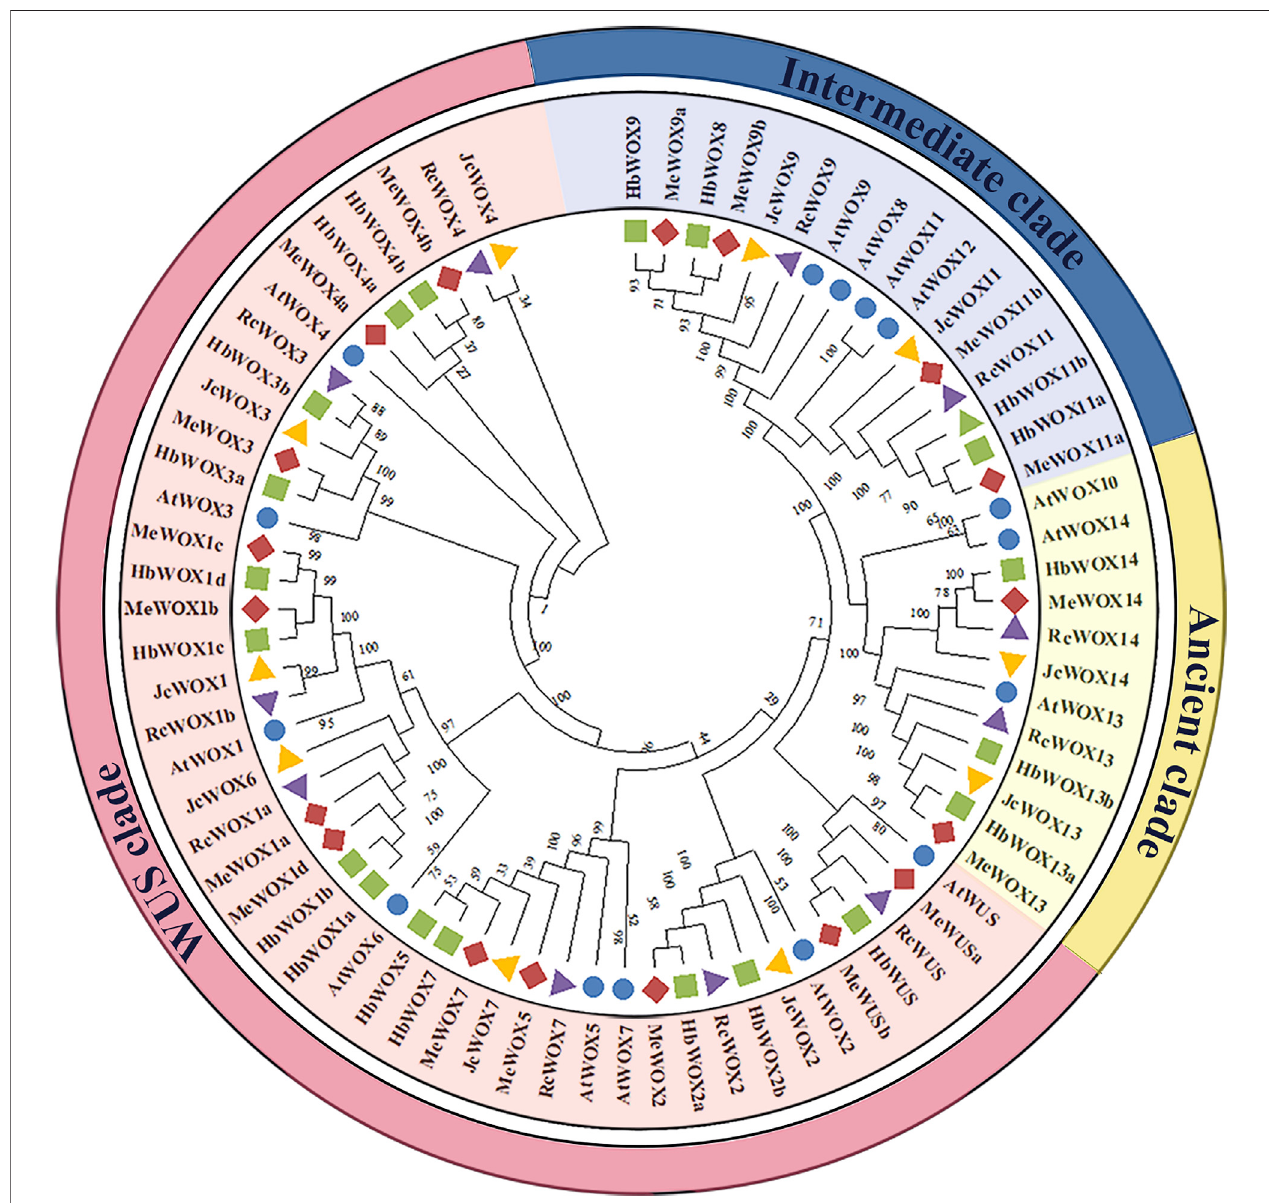
FIGURE1| Phylogenetictreeof WOX genesfromfourEuphorbiaceaespeciesand Arabidopsisthaliana .The fi veplantspeciesthataremembersofthe WOX gene familycanbedividedintothreemaincladeclasses,theancientcladeincludesthreesubfamilies,theintermediatecladeincludesthreesubfamilies,andthemodern/WUS clade contains eight